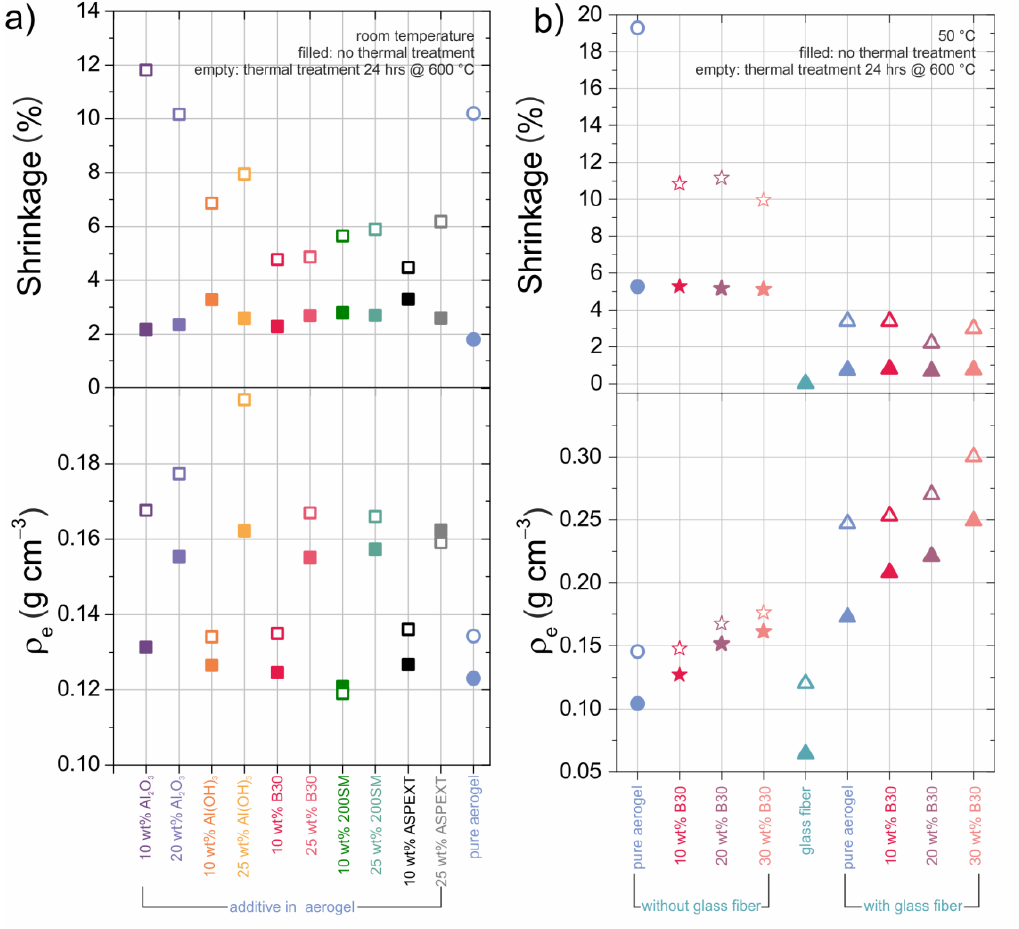
Figure 1. Density and radial shrinkage ratio of the pure silica aerogel (blue dots) and SAs combined with different ceramic opacifiers in varying concentrations before (filled) and after heat treatment for 24 h at 600 °C (unfilled). Two different synthesis temperatures were applied: room temperature ( a ) and 50 °C ( b ).